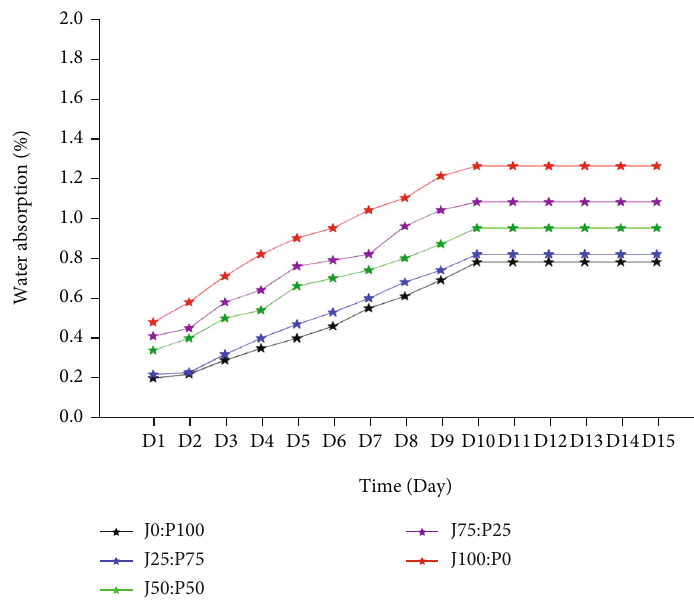
Figure 6: Water absorption jute/palm leaf fi ber-reinforced hybrid composites. Table 4: Comparison of mechanical properties of present hybrid composite with published